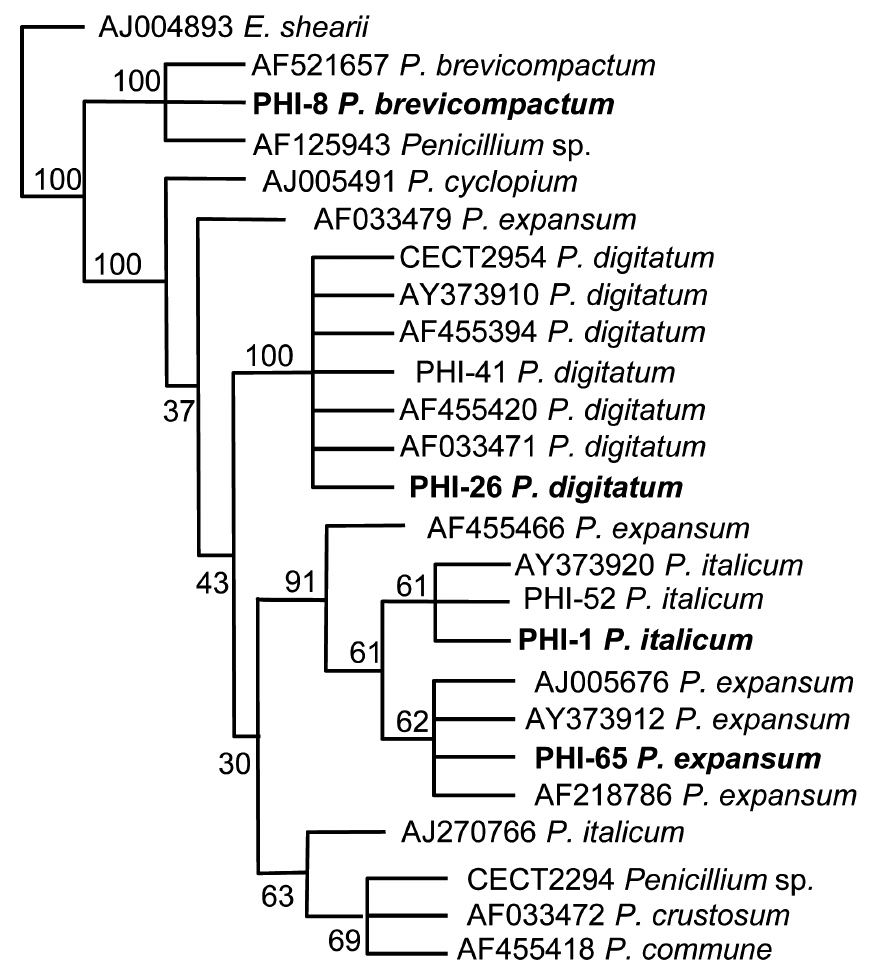
Figure 1. Phylogenetic tree reconstruction of Penicillium isolates based on the ITS ribosomal DNA sequence. Isolate sequences obtained from public databases are labelled with the accession number of the sequence. Isolates charac- terized in this study are indicated in bold. Additional fruit isolates PHI-41 and PHI-52, and strains CECT2294 and CECT2954 from “Colección Española de Cultivos Tipo” (CECT, Spanish National Collection of Type Cultures) were included as references. Numbers at nodes indicate the percentage of replicates in which the node was found, as determined by bootstrap analysis (1000 replicates). Accession numbers of the resulting sequences are: P.